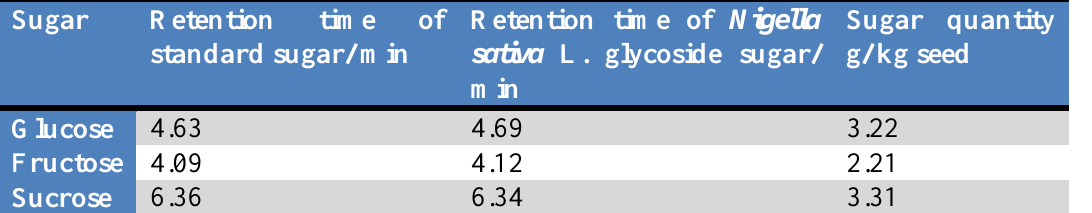
Table (2): High performance liquid chromatography analysis of the sugar fractions of the glycosides (flavonoids) of Nigella sativa L. on Shim-Pack CLC- NH2 column, using water: acertonitrile 3: 1 V/V at a how rate 1ml/min. as mobile phase and refractive index detector.